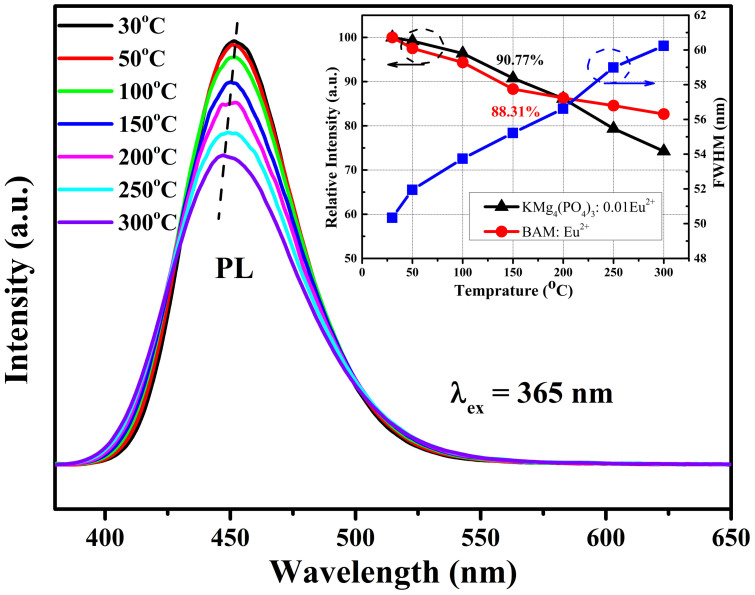
Temperature-dependent PL spectra of KMg4(PO4)3:0.01Eu2+.The inset shows a comparison of thermal quenching of KMg4(PO4)3:0.01Eu2+ with that of BAM:Eu2+ and dependence of the FWHM of KMg4(PO4)3:0.01Eu2+ emission on temperature.